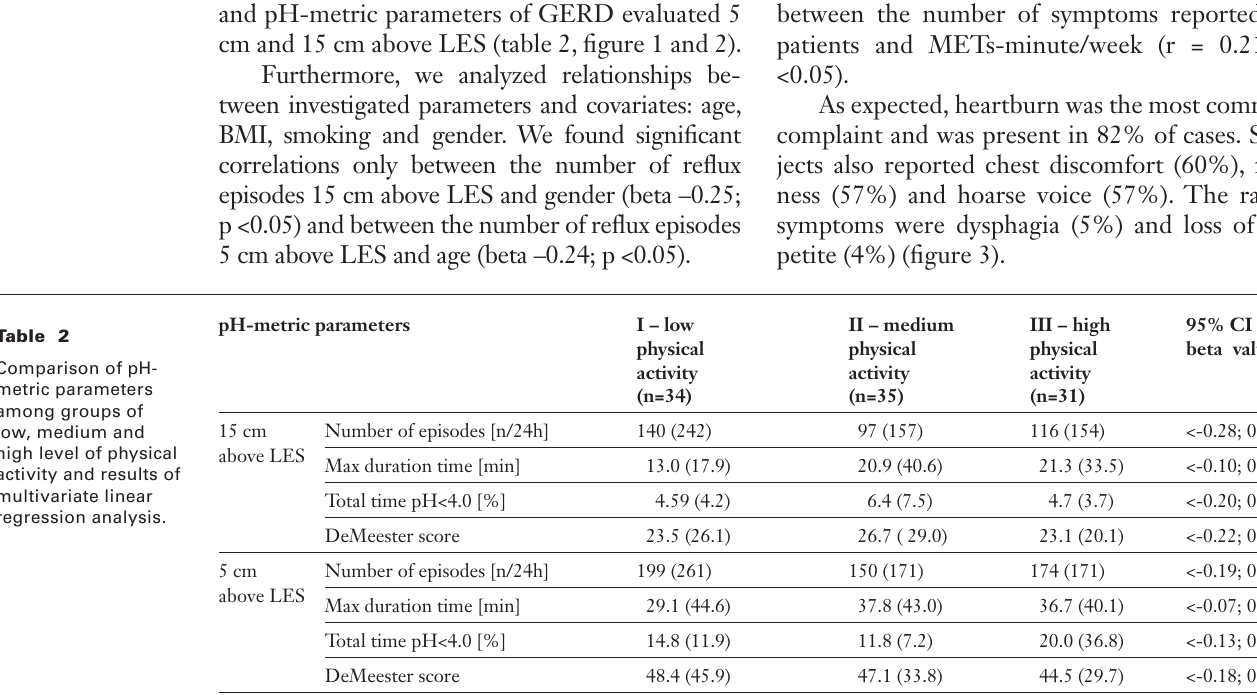
Figure 1 Correlations between the level of physical activity (METs- minute/week) and pH-metric parameters measured 15 cm above lower oe- sophageal sphincter